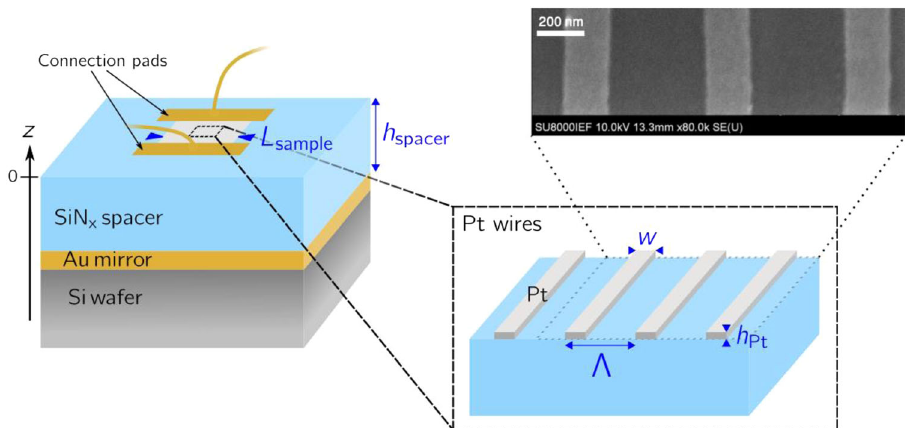
Fig. 1 Design of the emitter. Schematic view of the device. A periodic array of platinum wires ( w = 190 nm, h Pt = 25 nm, Λ = 595 nm) is deposited on a SiN x spacer ( h spacer = 1.15 µ m) above a gold mirror. Electrical contacts of the platinum wires are made with two gold electrodes. The device area is L 2 ¼ 100 ´ 100 µ m 2 and is directly prepared on a silicon wafer. The array of metallic wires is designed to have an electrical impedance of 50 Ω and an sample optical absorptivity of 0.8 at 5.1 µ m. Top right: SEM picture of some platinum wires. Scale bar,